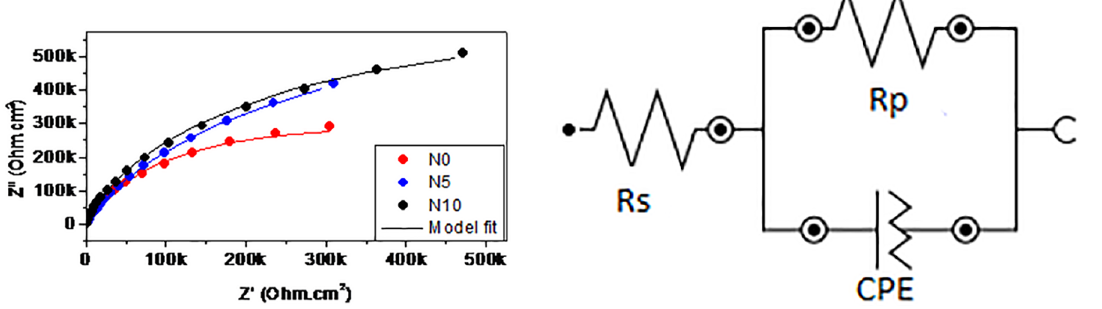
Figure 8. Equivalent electrical circuit used to adjust the experimental data of the impedance spectra.